Question: What kind of plot is shown here?
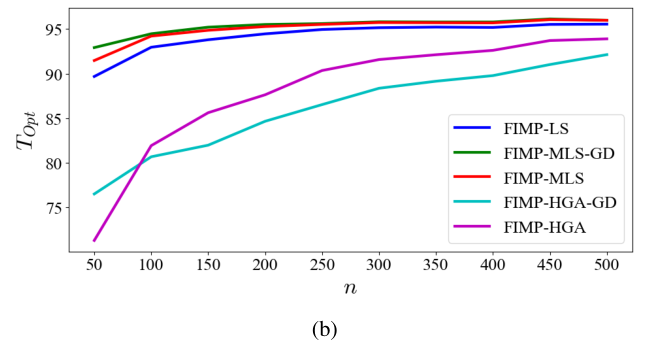
Answer: line